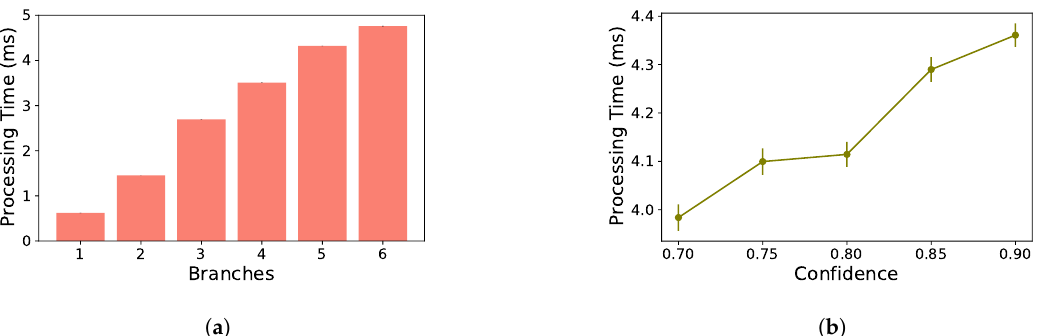
Figure 6. Processing time without cloud offloading. ( a ) Overall processing time in each branch. ( b ) Overall processing time as a function of the inference threshold p tar